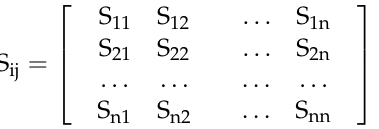
Figure 3. Average monthly water volume change in Erhai Lake from 2000 to 2019.